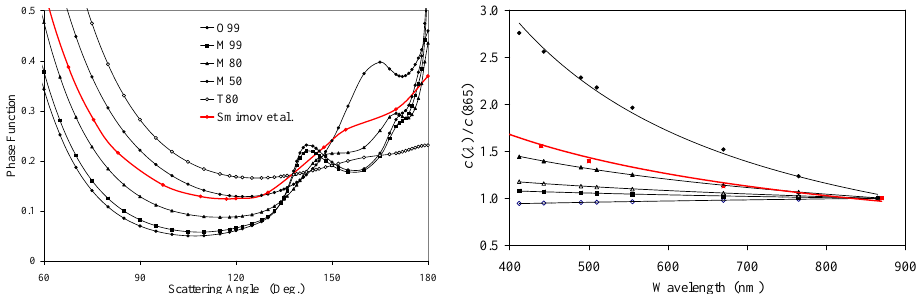
Figure 11. ( Left Panel ) Phase function (865 nm) computed using the Lanai size distribution compared with several Shettle and Fenn phase functions. Note, O99 is M99 without the small particle mode. ( Right Panel ) Spectral variation of the extinction coefficient size distribution (red) compared with several Shettle and Fenn models: filled diamonds—T80; filled triangles—M50; open triangles—M80; filled squares—M99; open diamonds—O99. The lines are regression fits to c ( λ ) ∝ λ − p . (Taken from